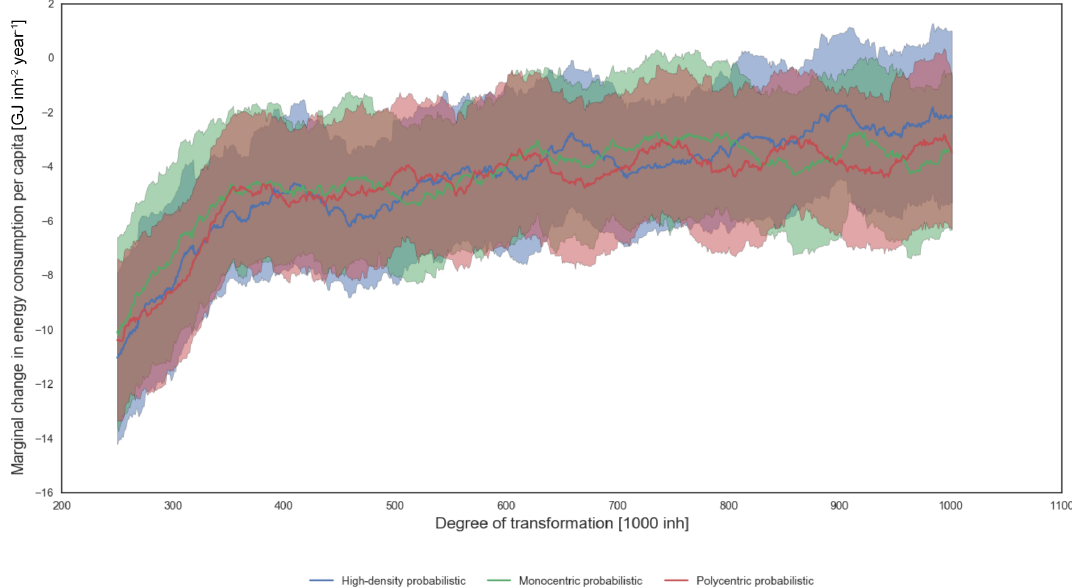
Figure 3. The moving average (50 model steps) of the marginal contribution to energy consumption for urban mobility when moving out 1000 inhabitants in each model step in the probabilistic model setting and its standard deviation do not visibly differ between city types. The overall trends show the expected decreased returns of the transformation efforts along the model steps.